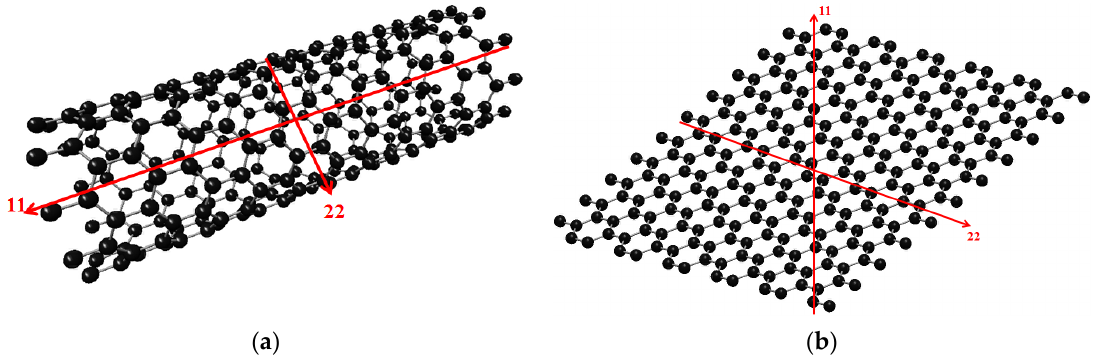
Figure 8. Representative cylindrical inclusion for CNTs ( a ) and ellipsoidal inclusion for GNPs ( b ).